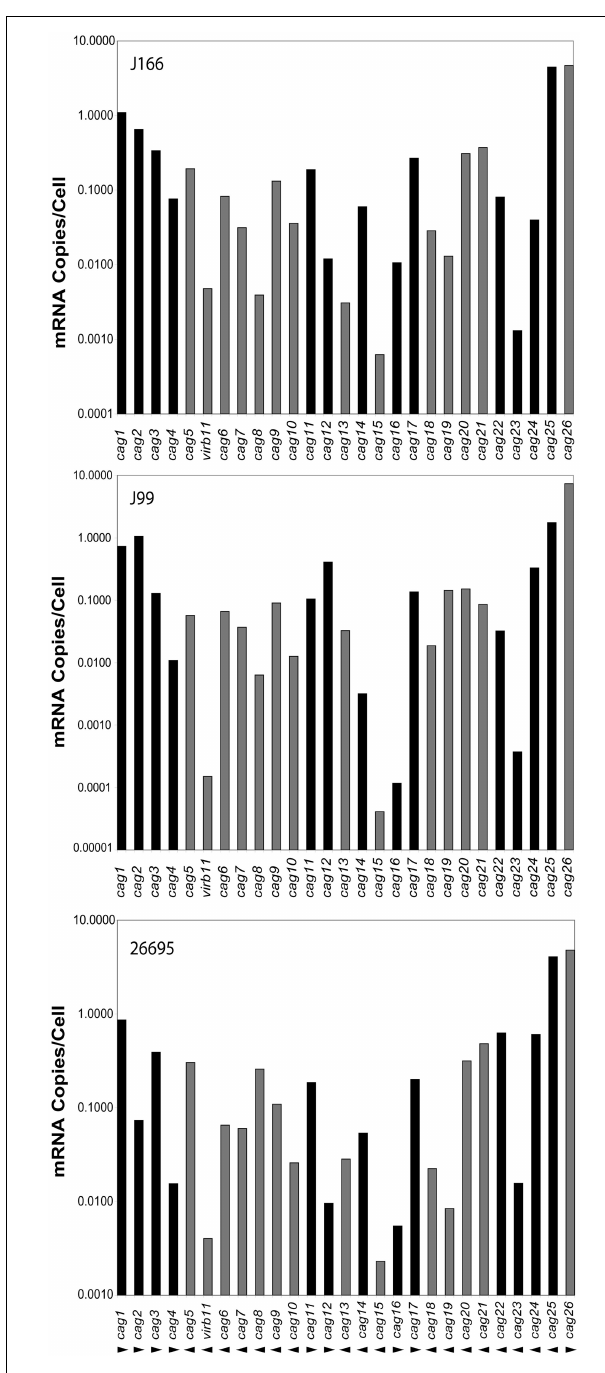
FIGURE 1 | Expression level of each gene on the cag PAI (mRNA copies/cell; normalized to 16S rRNA) for H. pylori strains J166 (top panel), J99 (middle panel), and 26695 (bottom panel). Our data represents the average of duplicate reactions. Adjacent genes for which intergenic transcript was detected are indicated with the same shading (black or gray). Direction of transcription is shown by arrowheads below the bottom panel. Since cag26 ( cagA ) is not contiguous with the PAI in H. pylori J166, the cag25-26 intergenic message was not measured, but presumed to be absent because cag25 and cag26 transcription is in opposite